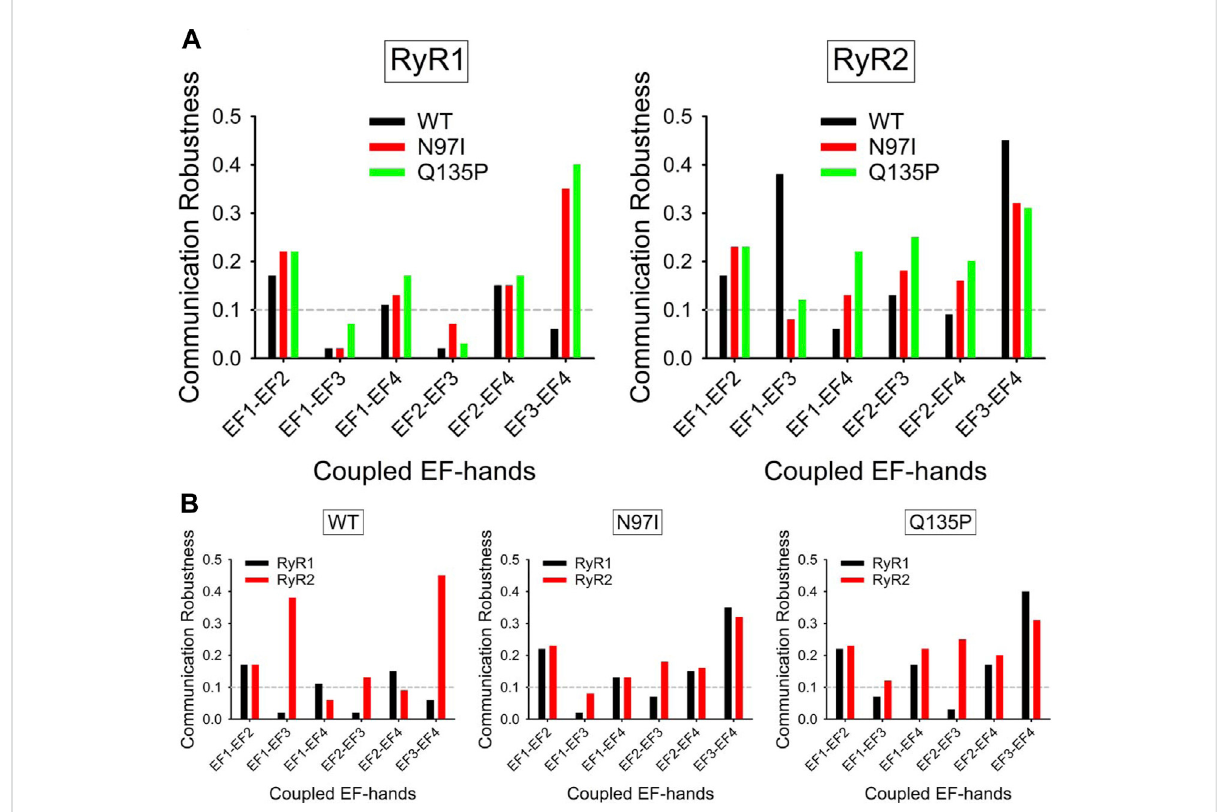
FIGURE 9 Robustness of intramolecular communication between EF-hands in CaM-RyR1/2 complexes. (A) Intramolecular communication among EF- hands in the CaM-RyR1 (left) and CaM-RyR2 (right) complexes. Communication robustness between EF-hands (EF1 to EF4, represented by their bidentateGluresidues)inCaMWT(black),N97I(red),andQ135P(green)variantsincomplexwithRyRpeptides. (B) Effectsofspeci fi cRyRpeptideson the intramolecular communication among EF-hands in CaM-RyR complexes. Communication robustness between EF-hands (EF1 to EF4, represented by their bidentate Glu residues) in CaM variants in complex with RyR1 (black) and RyR2 (red)